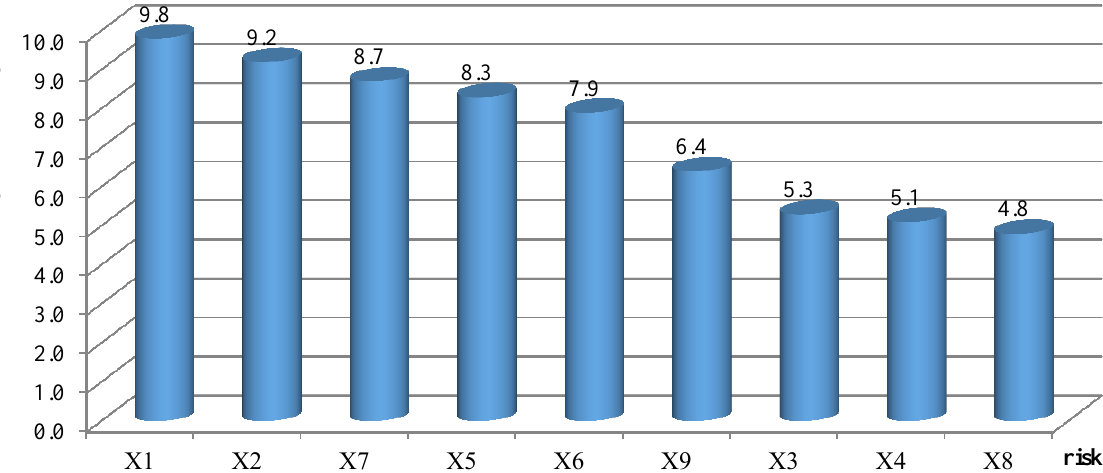
Fig. 1. Histogram of the distribution of types of logistics activities risks in FEA characteristic for pharmaceutical enter-